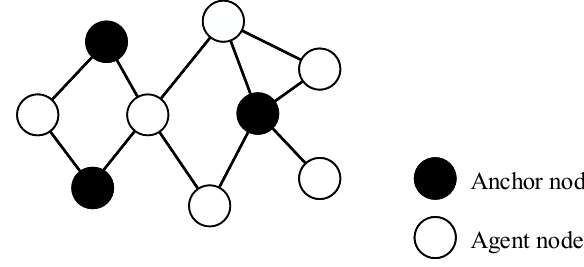
Figure 1. Illustration of the localization system.